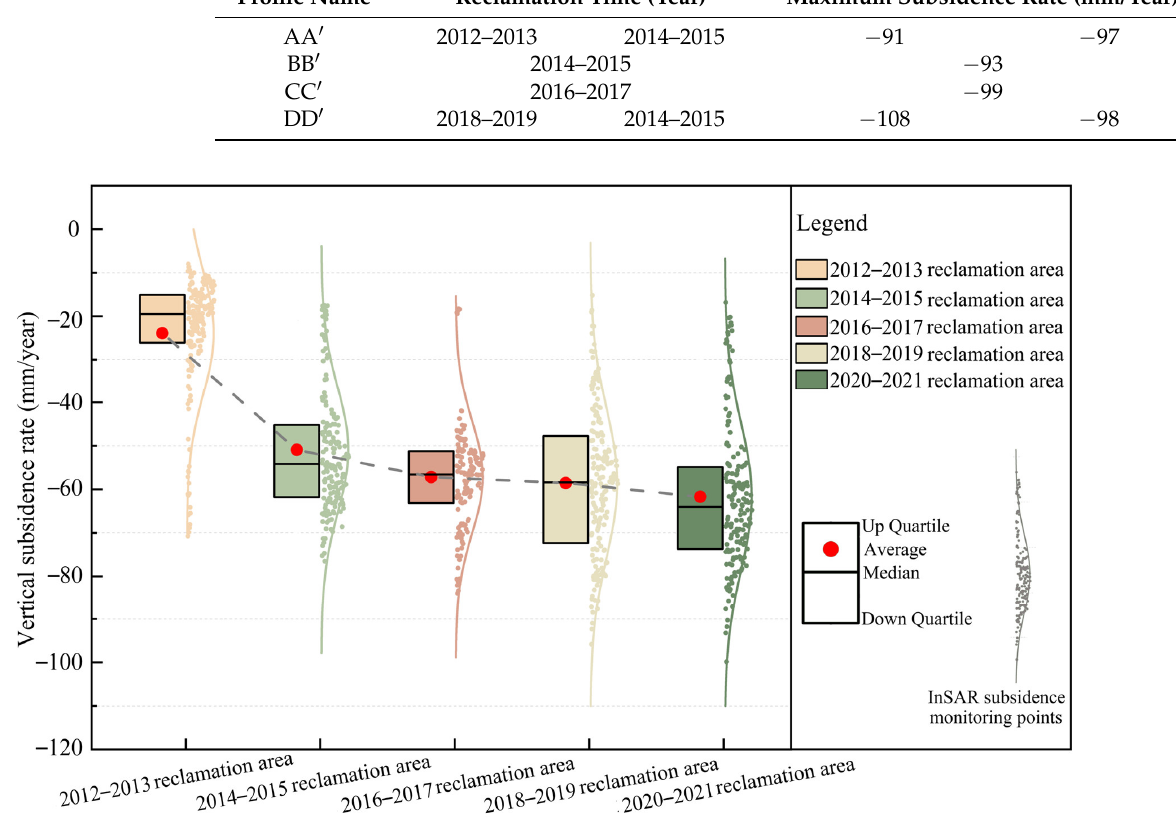
Figure 10. Temporal distribution of average vertical subsidence rates in different reclamation